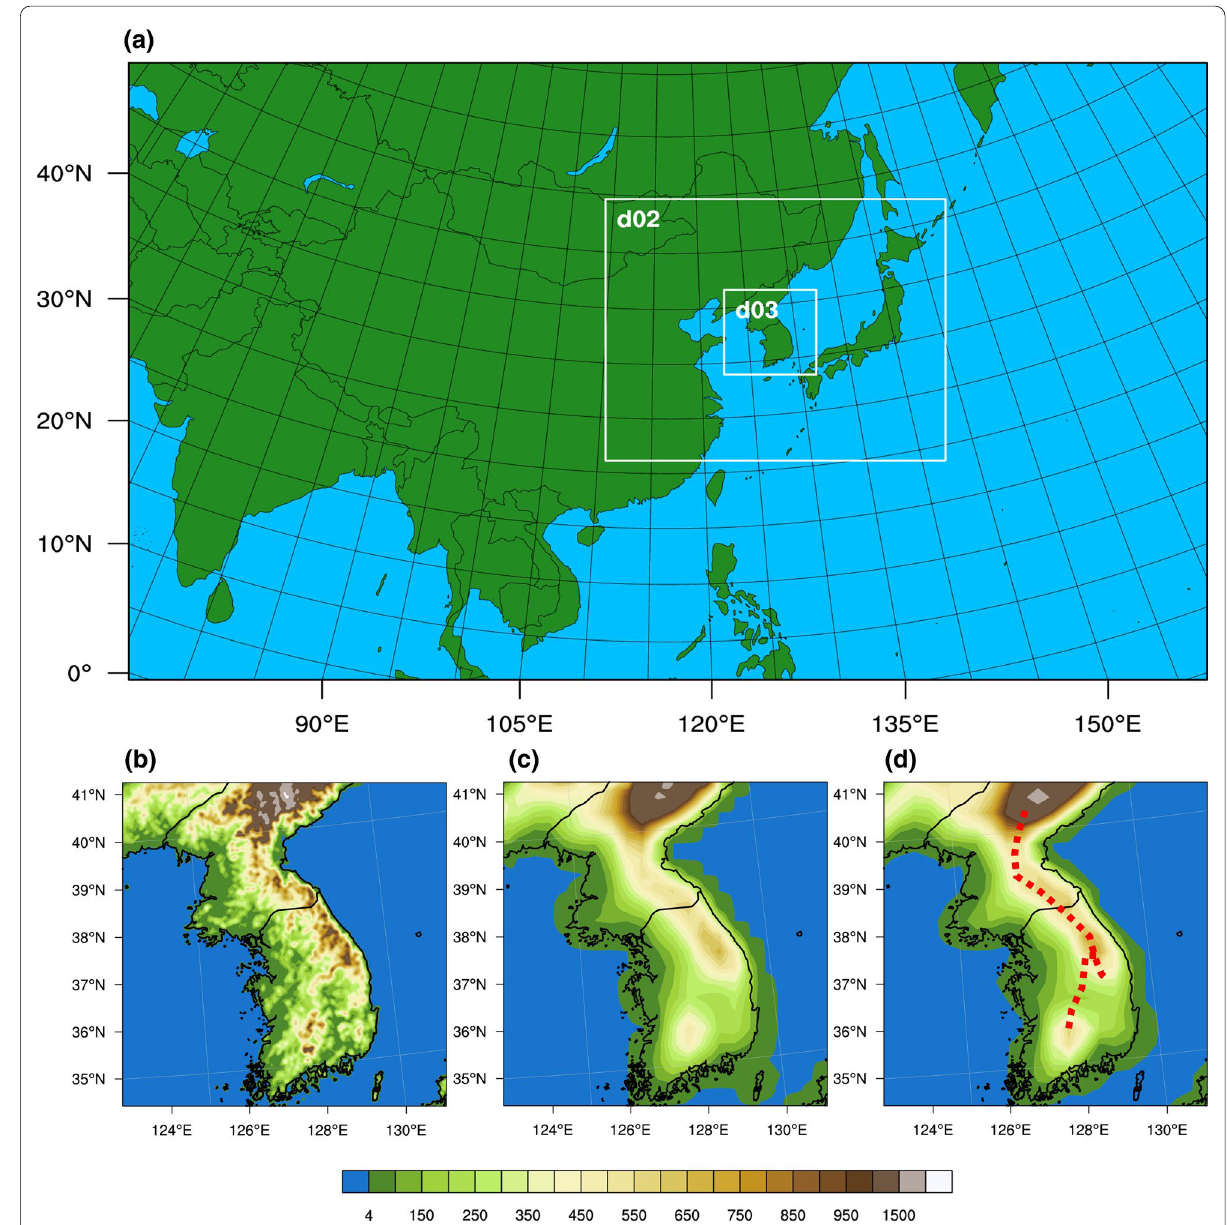
Fig. 1 a WRF model domains with two nests and b – d topography (m) of the innermost domain in CTRL04, LOW04, and CTRL36, respectively. The dashed red lines indicate the mountainous